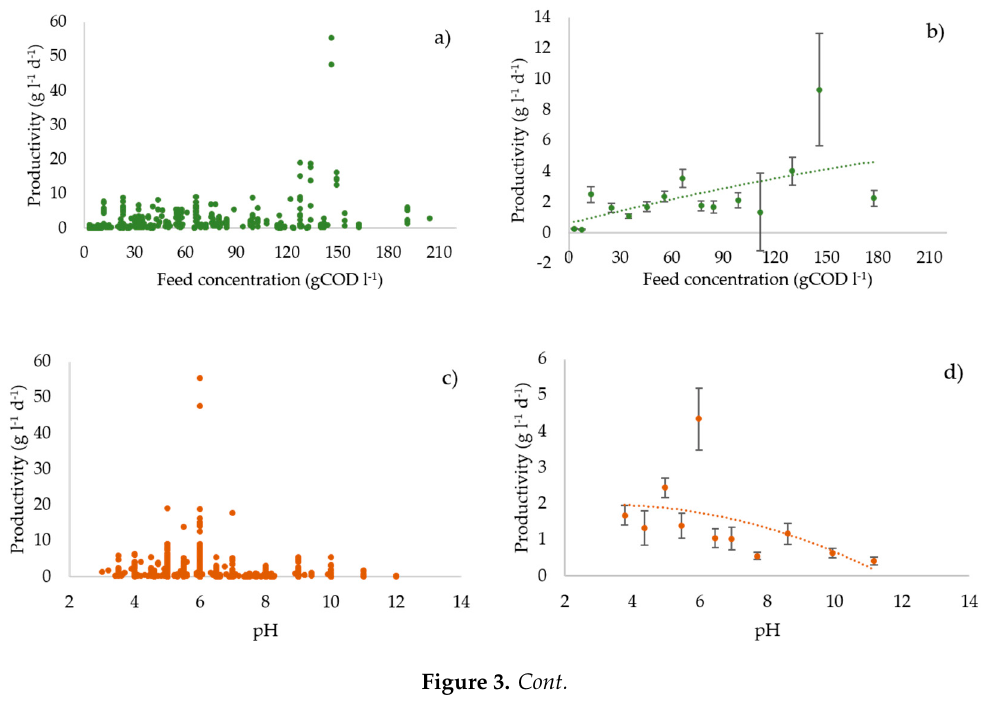
Processes 2020 , 8 , x FOR PEER REVIEW